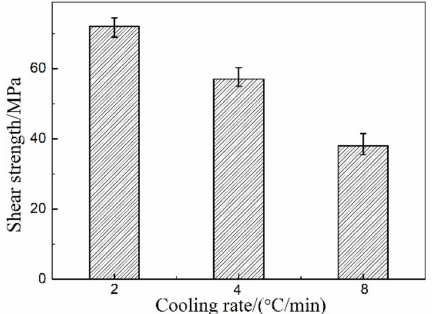
Figure 6. Shear strength of the brazed SiC ceramic joint with di ff erent cooling